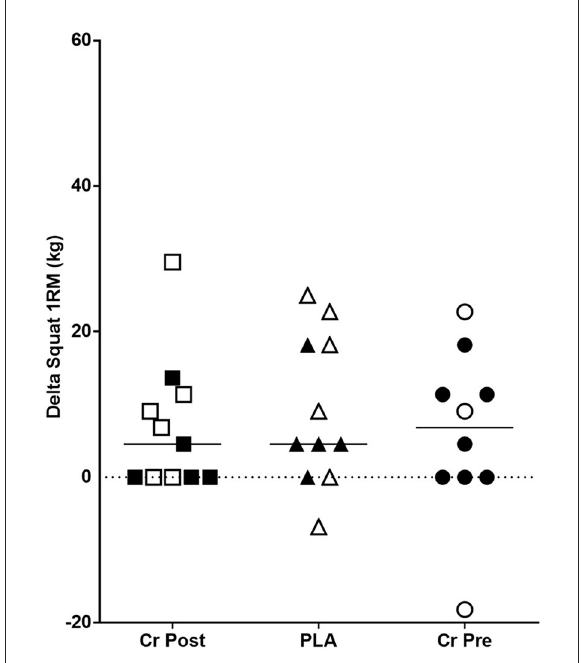
FIGURE4 Change in squat 1RM performance (Week 8 - Week 0) in kilograms. Cr Post, Post-exercise creatine supplementation; Cr Pre, Pre-exercise creatine supplementation; PLA, Placebo supplementation. For each respective shape, the filled shapes ( (cid:4)N • ) are female participants, and the non-filled shapes ( △ ◦ (cid:3) ) are male